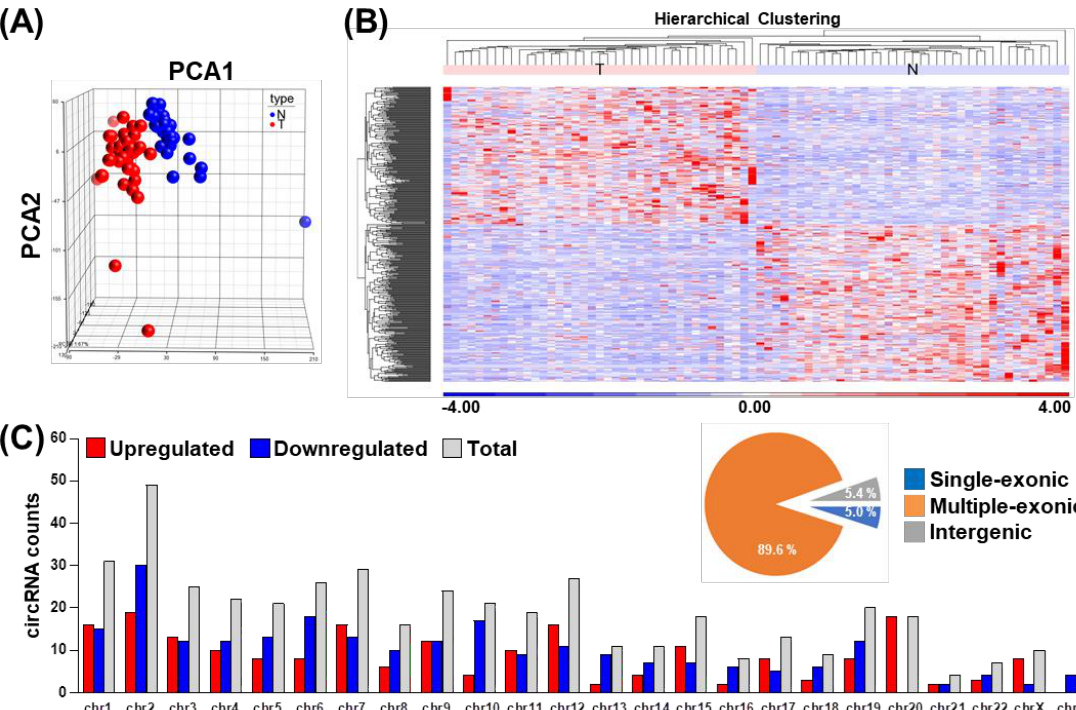
Figure 1. The circRNA transcriptome landscape in primary oral squamous cell carcinoma (OSCC) tumor tissues. Using the OSCC RNA-seq dataset, circRNA expression levels were determined based on the normalized read count values. ( A ) Principal component analysis (PCA) of normal vs. tumor tissues generated on the basis of identified circRNAomes. ( B ) Hierarchical clustering analysis of circRNAs di ff erentially expressed in tumor vs. normal tissues ( n = 443), which illustrates the distinction of di ff erential expression profiles corresponding with disease state. ( C ) The distribution of di ff erentially expressed circRNAs on the basis of chromosomal location. Sequence composition for circRNAs, including single-exonic, multiple exonic, and intergenic types are presented as circle plot in the upper right